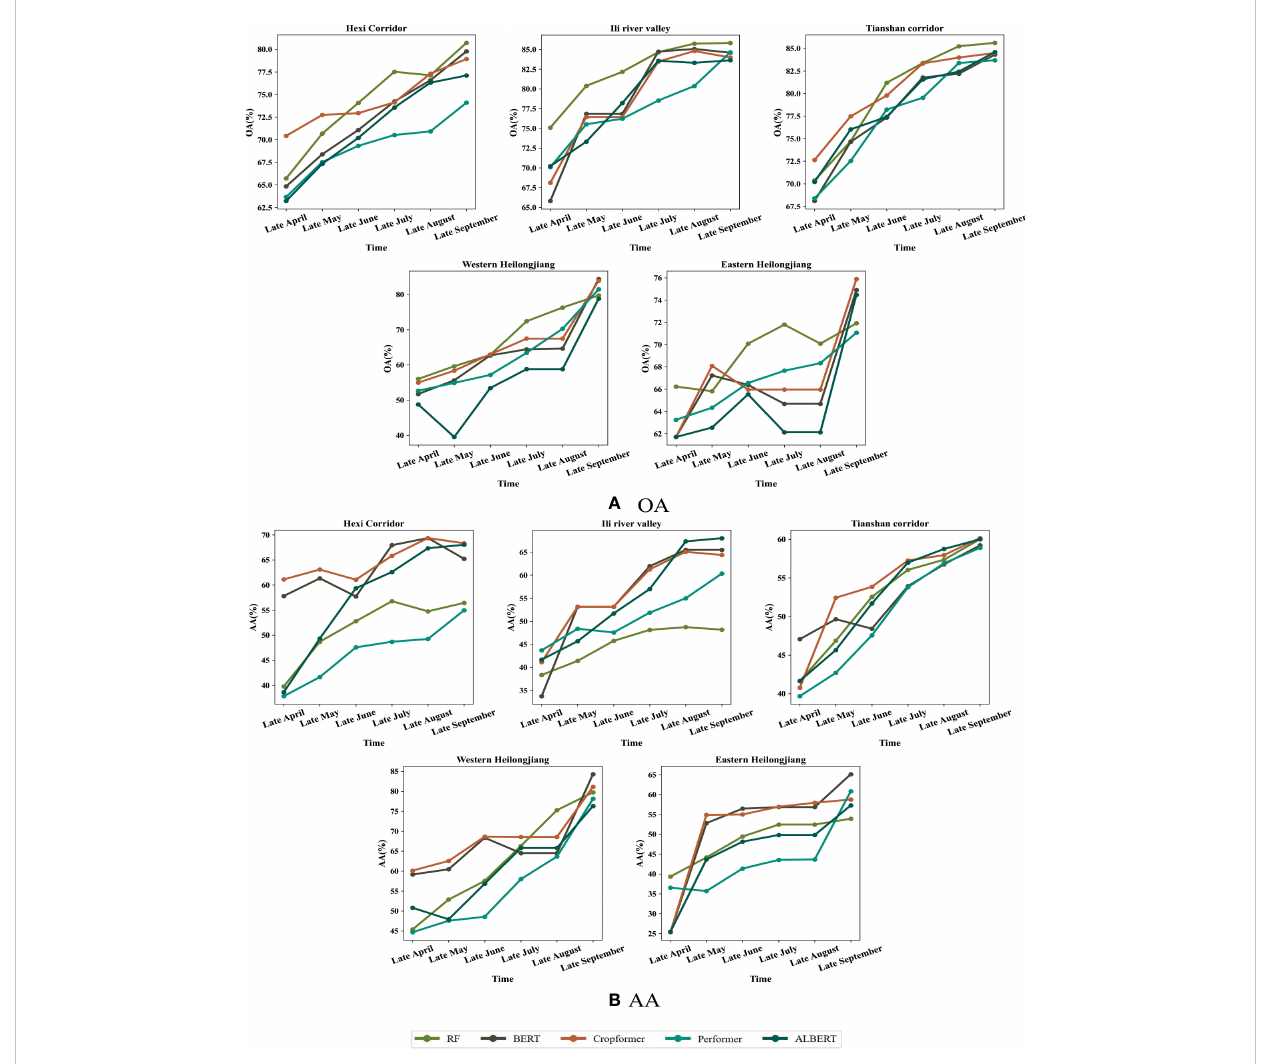
FIGURE 8 Early detection results with time transformation in the fi ve study areas. The fi rst row of which is OA and the second row is AA for the period from the end of April to the end of September. (A) OA for in-season crop classi fi cation (B) AA for in-season crop classi fi